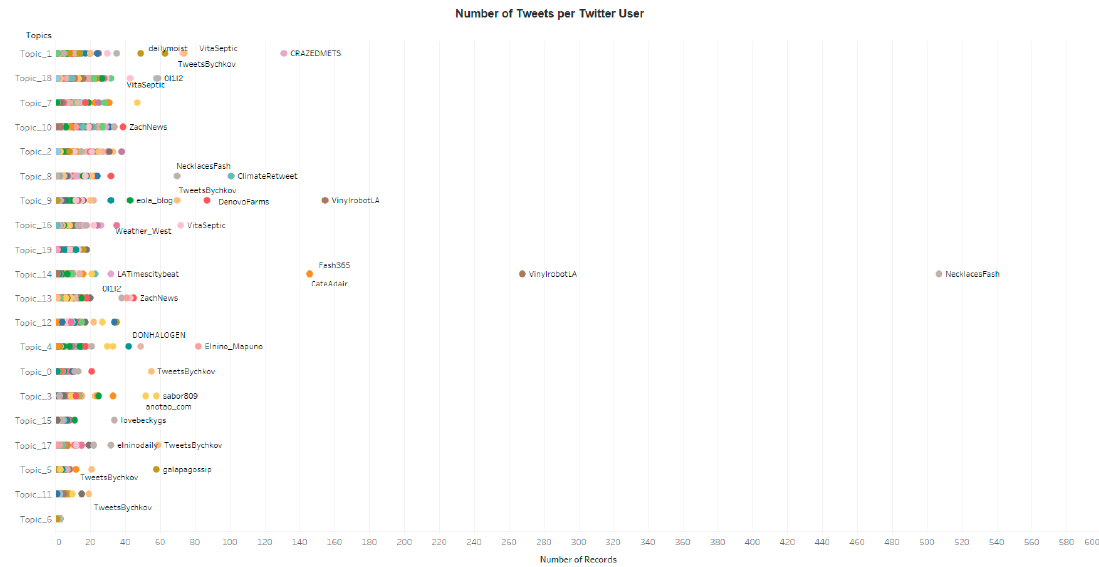
Figure 13. Number of tweets per Twitter user.